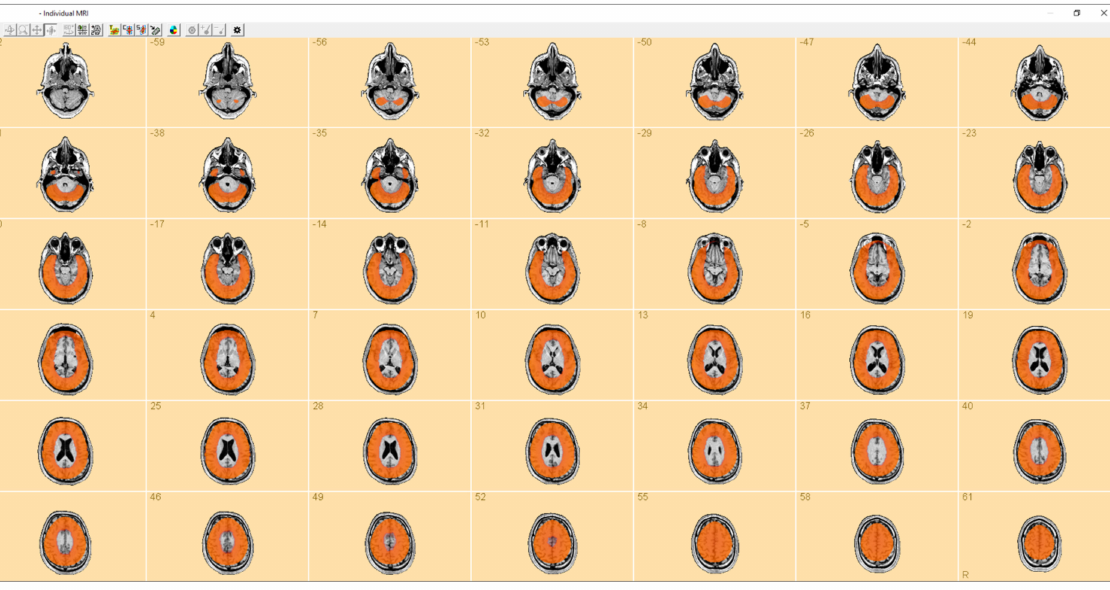
Figure A2. All brain regions closer than 75 mm to the sensors are indicated by orange